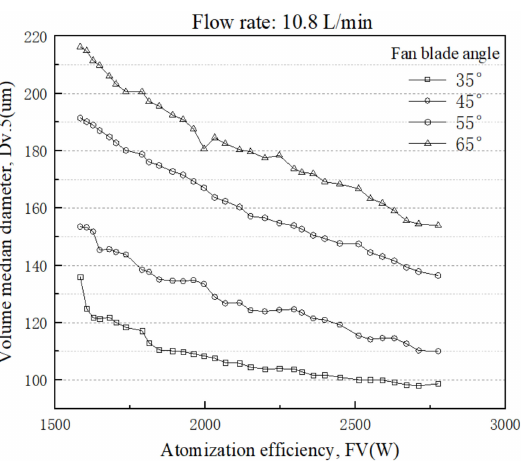
Figure 3. Relationship between power and droplet VMD for different atomizer fan blade angles at a flow rate of 10.8